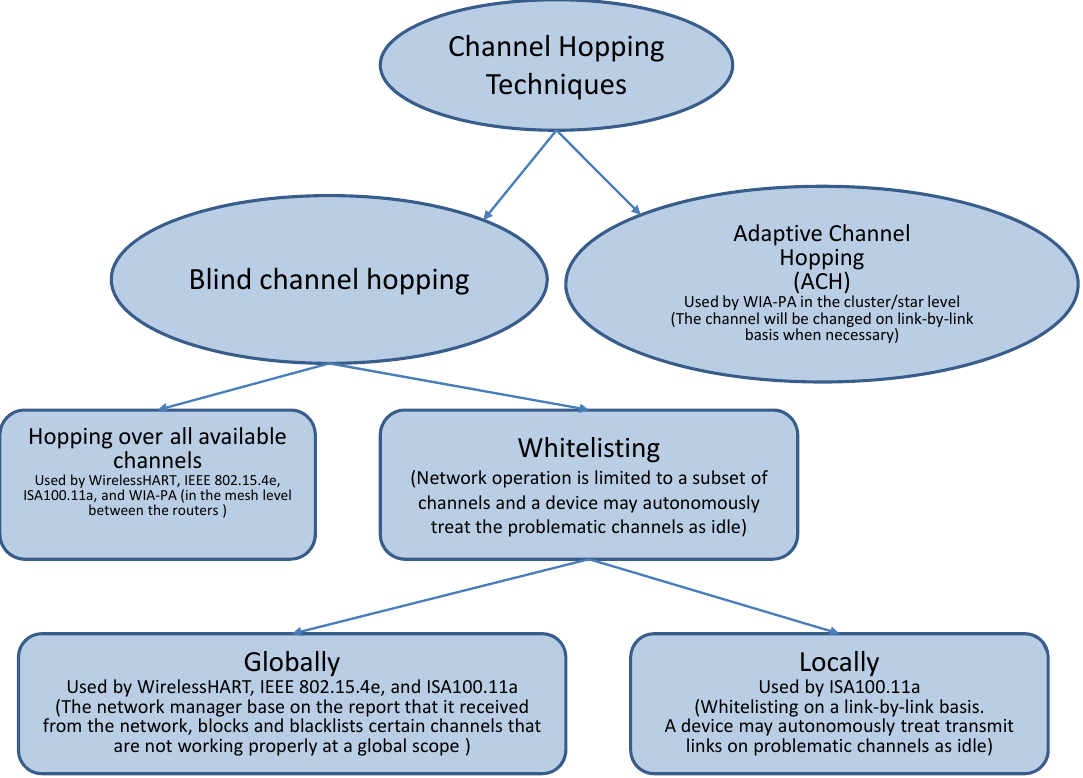
Figure 3. Channel hopping techniques.